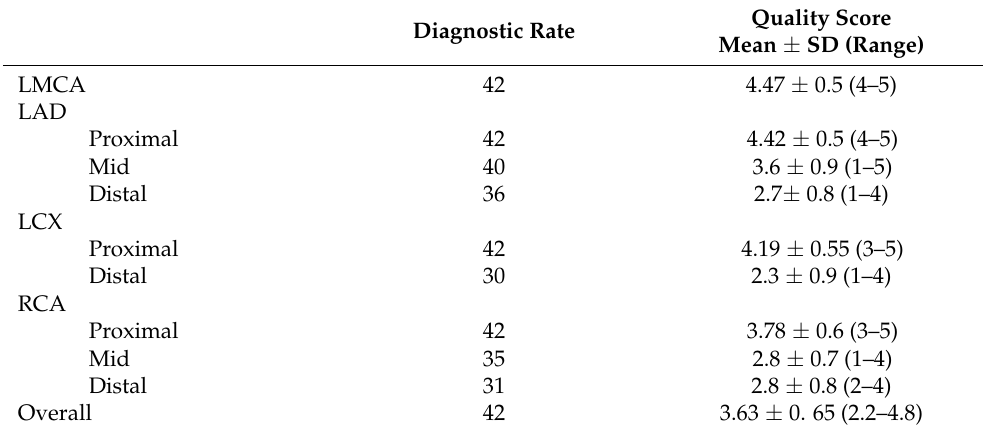
Table 5. Diagnostic rates and image quality scores for all coronary segments.